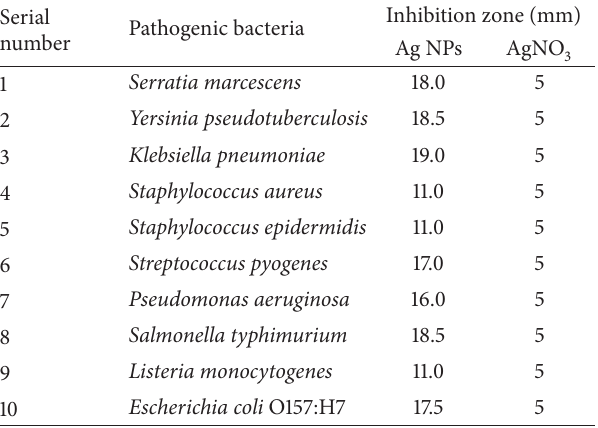
Table 2: Diameter zone of inhibition by Ag NPs and AgNO 3 against human pathogenic